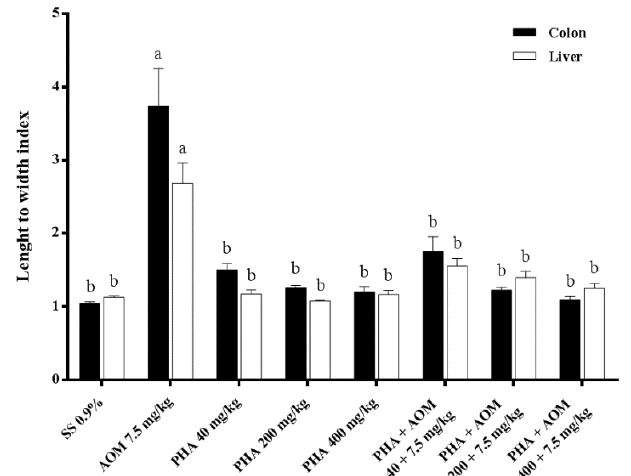
Figure 6. Effect of phaseolin (PHA) on the DNA damage induced with azoxymethane (AOM) in the colon and liver of mice. Each bar represents the mean ± SEM obtained from six mice per group, 100 nucleoids per mouse. a Statistically significant difference with respect to the control, saline solution (SS)-treated mice, and b with respect to the value obtained in the AOM-treated group. ANOVA and Holm-Šídák tests p < 0.05.